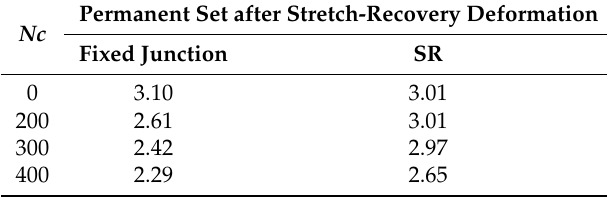
Table 3. Permanent set in all systems after the stretch-recovery deformation.